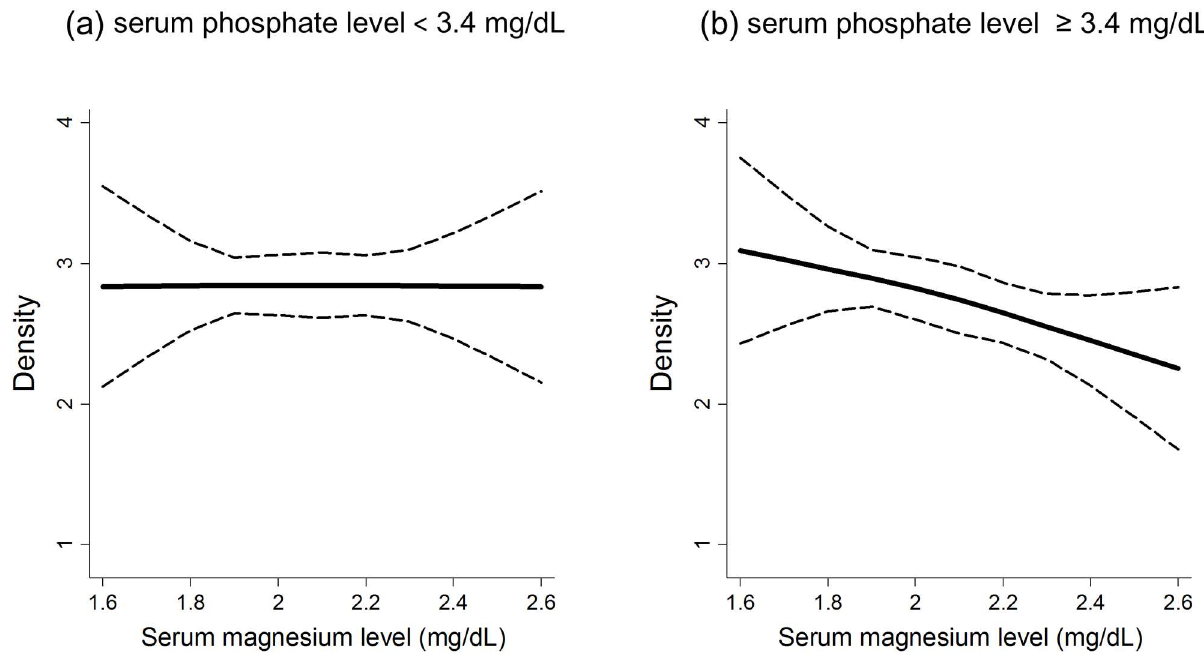
Fig 3. Cubic spline curves for the relationship between serum magnesium level and the coronary artery calcification density. (a) serum phosphatelevel < 3.4 mg/dL, (b) serum phosphate level (cid:21) 3.4 mg/dL. The model was adjusted for age, systolic blood pressure, estimated glomerularfiltration rate, and adjusted serum calcium levels. The dashed line represents the 95% confidence interval.